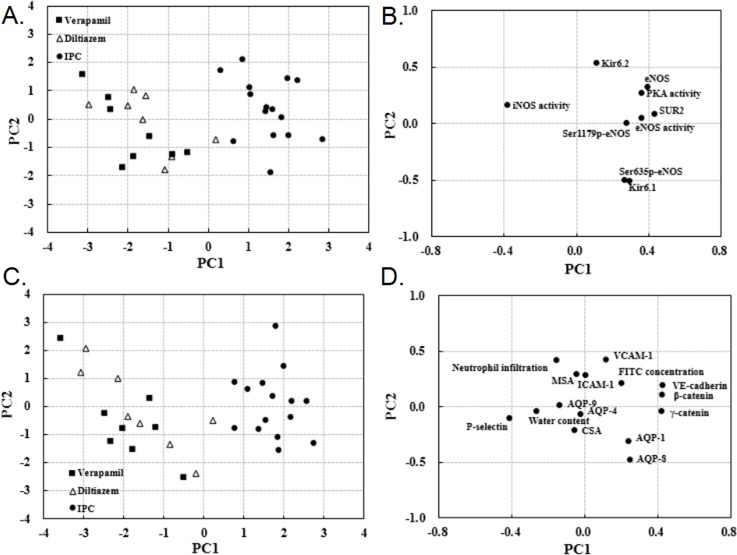
Principal component scatter plot and factor loadings.PCA scores (A, C) and loading plots (B, D) for the two principal components derived from scores of separate PCA constructed separately for endothelial structure-function network data from the IPC, verapamil and diltiazem groups. A: Difference in functional indices is significant in principal component 1 (PC1) between CCB and IPC groups. B: Loading plots shows that functional indices including SUR2, eNOS, iNOS activity, PKA activity and eNOS activity mainly account for the difference in PC1. C: Difference in structural indices is significant in PC1 between CCB and IPC groups. D: Loading plots shows functional indices including VE-cadherin, β-catenin, γ-catenin and P-selectin mainly account for the difference in PC1.